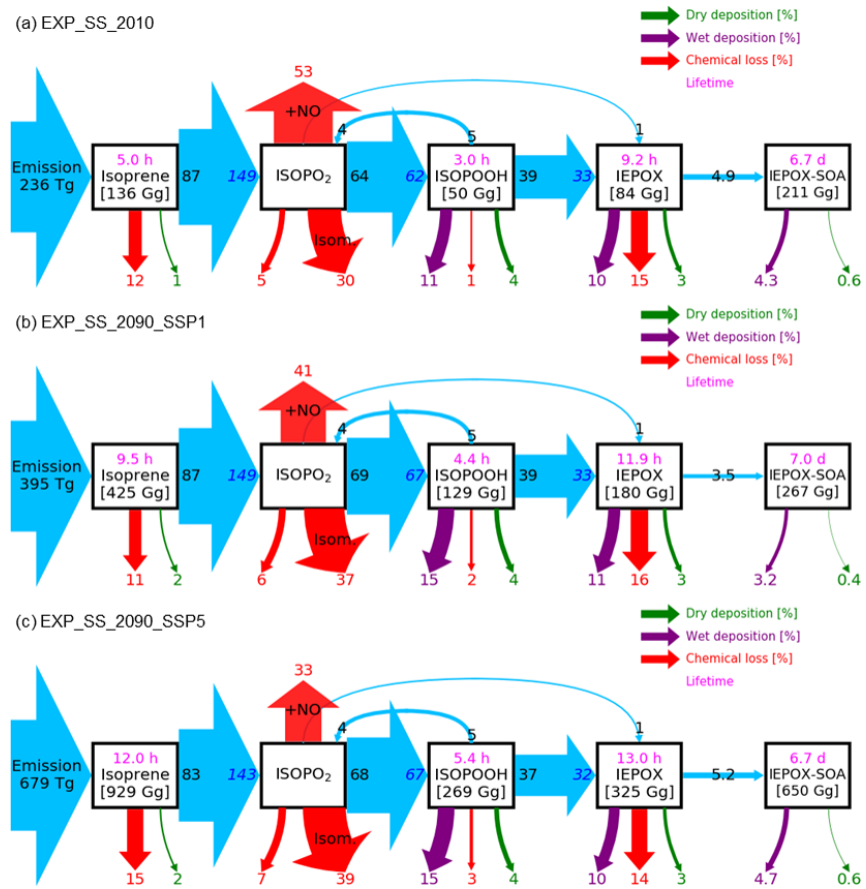
Figure 8. Same as Fig. 6 but for EXP_SS simulations (including sea salt in aerosol pH